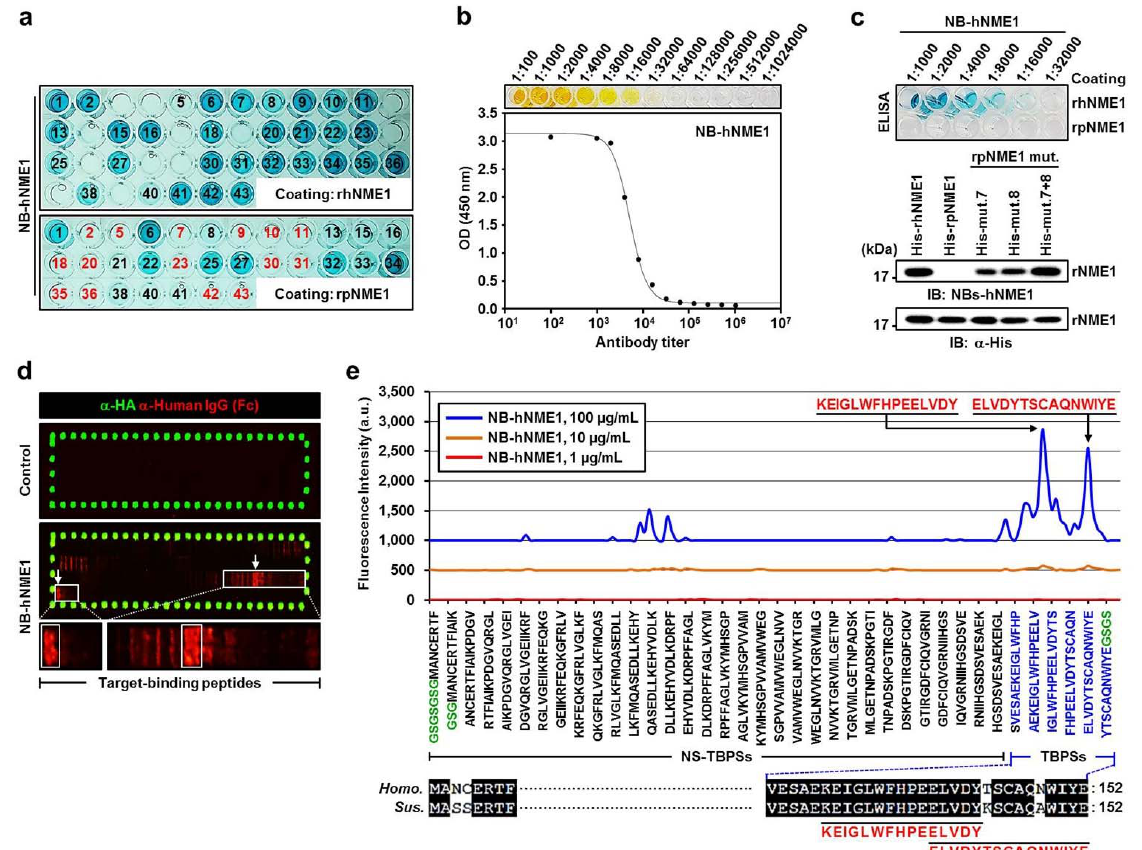
Figure 6. NB-hNME1 production and NME1 antigenic epitope mapping. ( a ) Detection of hNME1 antigen-specific antibodies by phage ELISA. Of 43 different colonies, 31 colonies (black number) were positive for rhNME1. Of these 31 rhNME1-positive colonies, 17 were used in the experiment; 15 colonies (red number) negative for rsNME1 were excluded. ( b ) Titer determination of NB-hNME1 by ELISA. The ratio of NB-hNME1 absorbance values at 450 nm. ( c ) The specificity of the hNME1 antigen in NB-hNME1 was confirmed by ELISA and IB analysis. Results were analyzed by SDS-PAGE followed by IB analysis with the NB-hNME1 and α -His antibody, which demonstrated that NB-hNME1 is attached only to His-rhNME1, His-mut. 7, His-mut. 8, and His-mut. 7+8. α -His antibody was used as a loading control. ( d ) The elongated antigen sequence was translated into 15 amino acid peptides with a peptide–peptide overlap of 14 amino acids. The resulting peptide microarrays contained 152 different peptides printed in duplicate (304 peptide spots) and were framed by additional HA (YPYDVPDYAG, 58 spots) control peptides. Goat α -human IgG (Fc) was used as secondary antibody; mouse monoclonal α -HA antibody was used as control. White squares indicate NB-hNME1-binding peptide; arrows indicate enlarged images. ( e ) Identification of a binding region of hNME1 interacting with NB-hNME1. A peptide array of hNME1 was exposed to NB-hNME1 at concentrations of 1, 10, and 100 µ g/mL. The intensity plot of the peptide array signals appears as peaks with corresponding regions of hNME1. The two highest peaks are denoted with arrows in the graph, indicating two epitope-like spot patterns formed by adjacent peptides with the consensus motifs KEIGLWFHPEELVDY and ELVDYTSCAQNWIYE. GS (green text), neutral linkers at the C- and N-terminus; NS-TBPSs, nonspecific target-binding peptide sequences; TBPSs, target-binding peptide